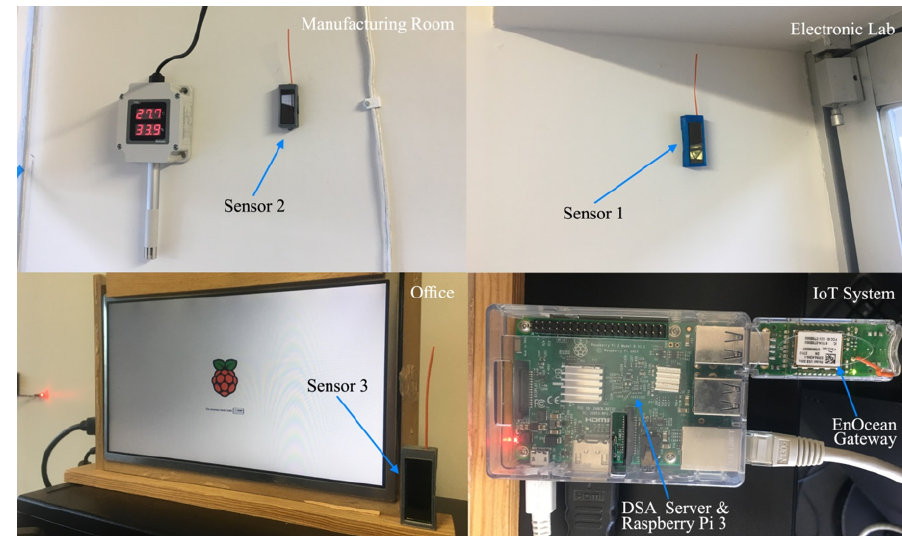
Figure 4. Location of the three temperature sensors inside enclosures.